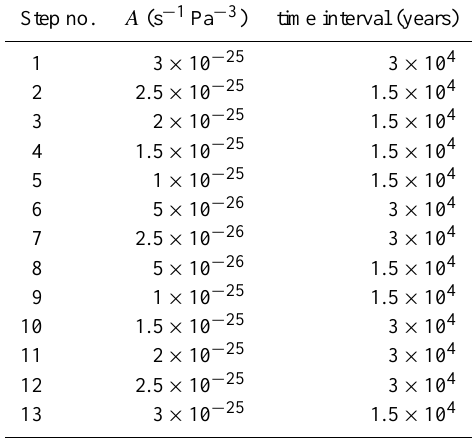
Table 5. Values of A and time intervals used in EXP